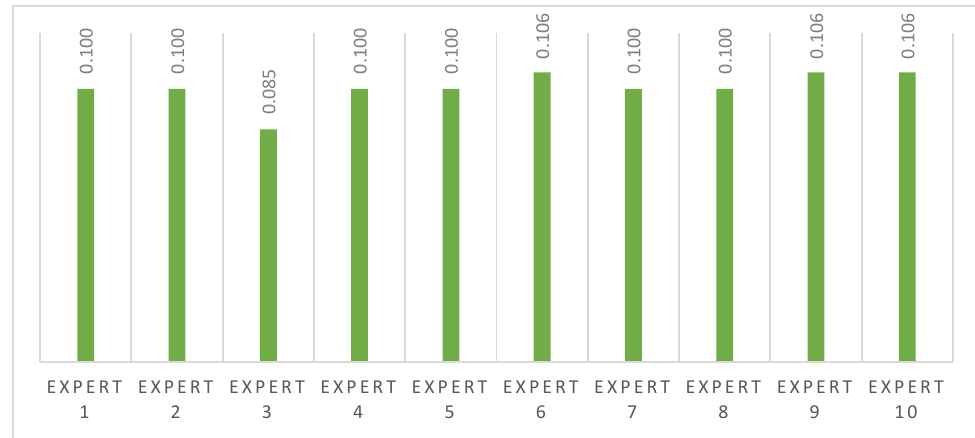
Figure 3. Experts ’ weights. Figure 3. Experts’ Table 5. The defuzzied total influence matrix construction.